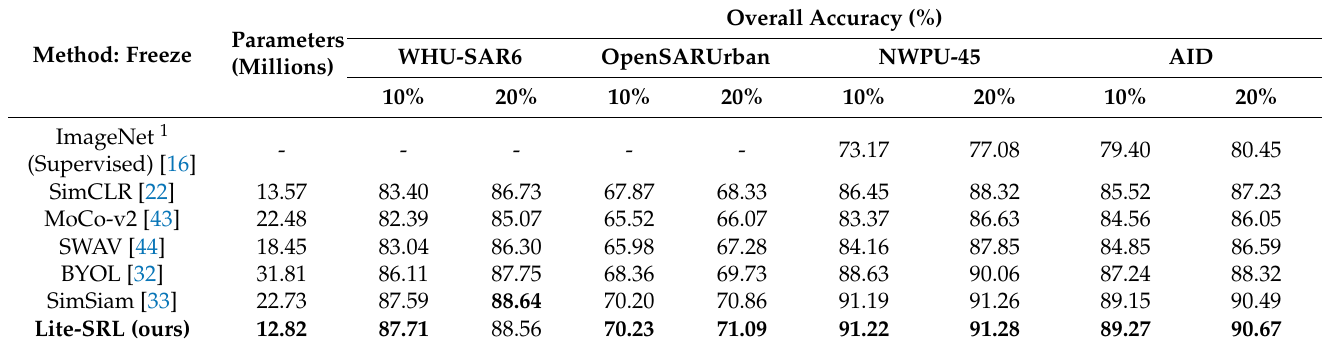
Table 2. Results of freeze experiment in terms of overall accuracy (%).